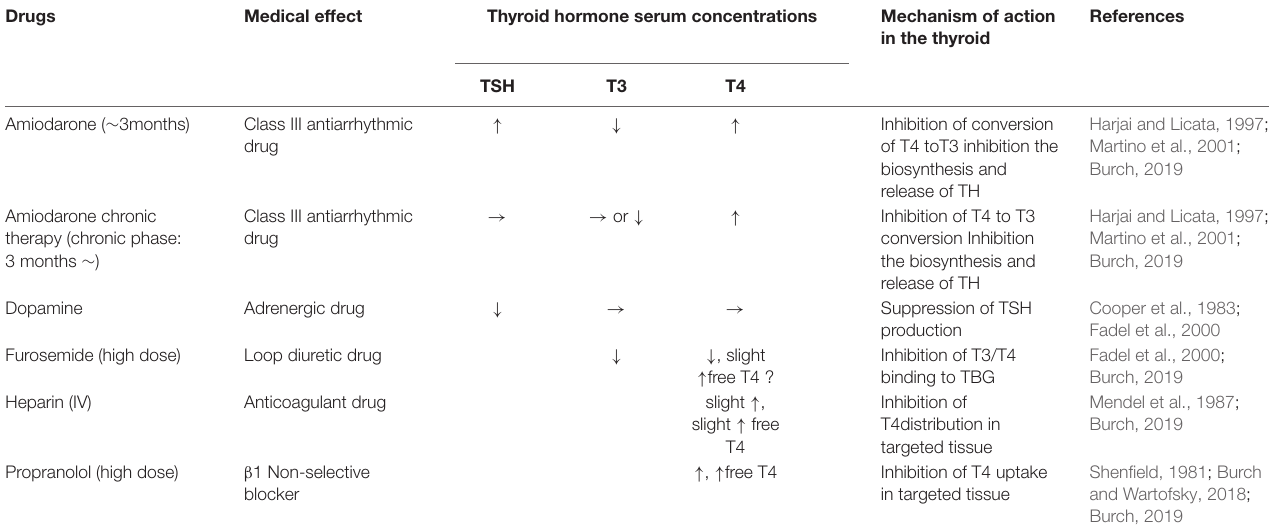
TABLE 3 | Effect of cardiovascular drugs on thyroid hormone function [modified from reference (Fadel et al., 2000; Burch,